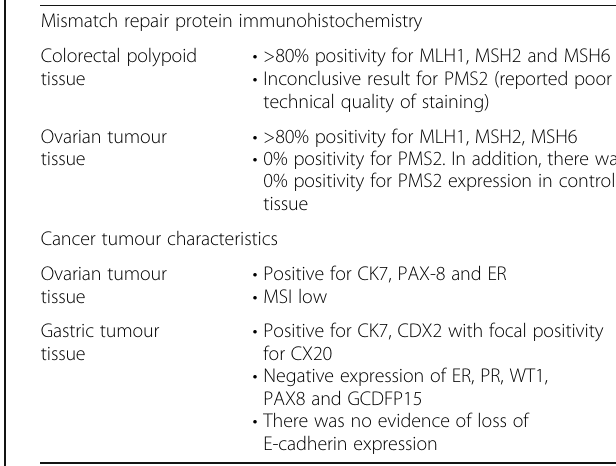
Table 1 Molecular analysis of polypoid and cancerous tumour tissue resected from the